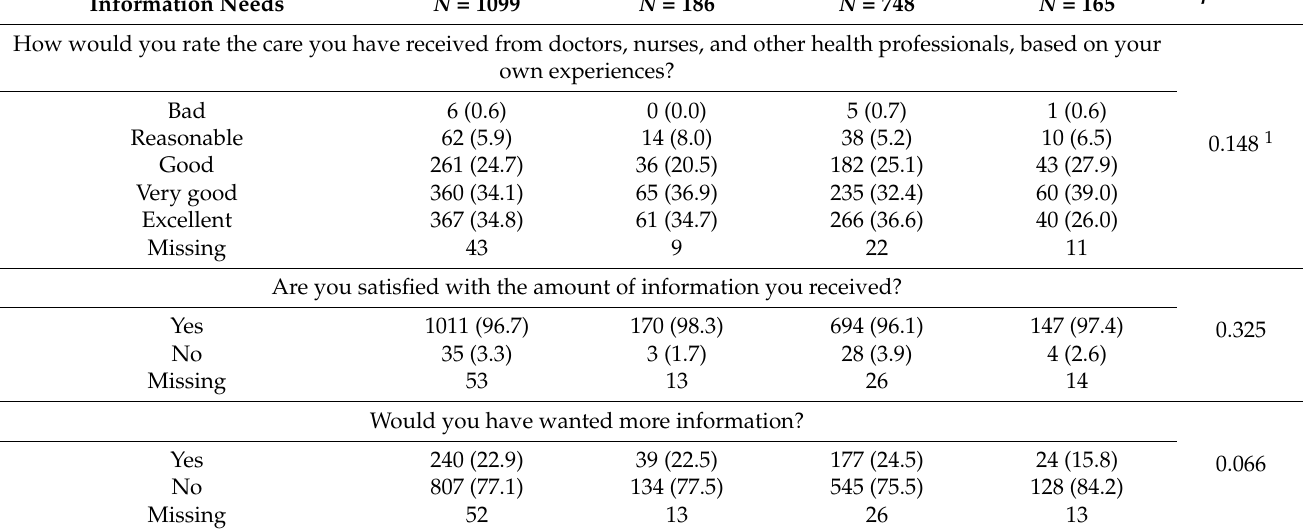
Table 3. Satisfaction with care and information needs in rare cancer patients. Satisfaction with Care